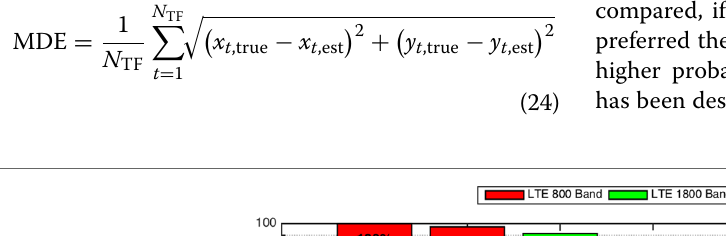
where N TF represents the overall number of test finger- prints extracted from all the test points.